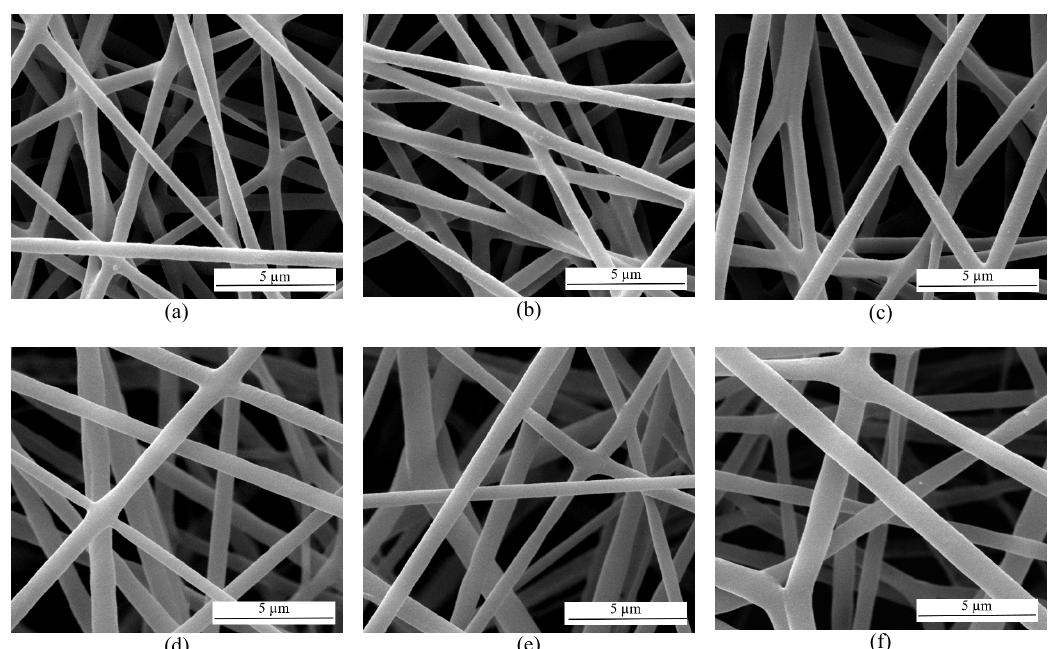
Figure 2. SEM images of the Plai oil-loaded fiber blend prepared at 12% polymer concentration with different PLA/PEO ratios: ( a ) PLA/PEO (90:10) + Plai oil, ( b ) PLA/PEO (80:20) + Plai oil, ( c ) PLA/PEO (70:30) + Plai oil, and their corresponding images after three months storage: ( d ) PLA/PEO (90:10) + Plai oil, ( e ) PLA/PEO (80:20) + Plai oil, and ( f ) PLA/PEO (70:30) + Plai oil. Table 1. Mean fiber diameters of electrospun